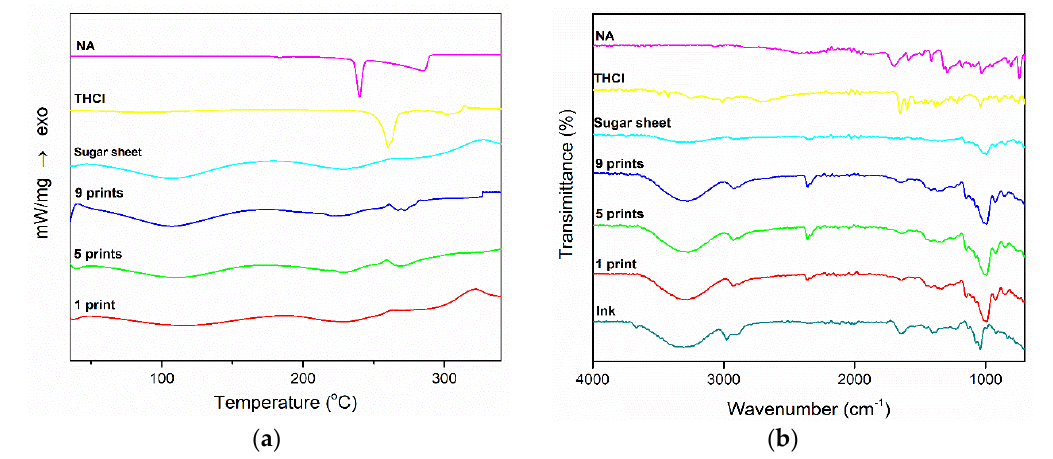
Figure 4. ( a ) DSC thermograms and ( b ) FTIR spectra of the samples.